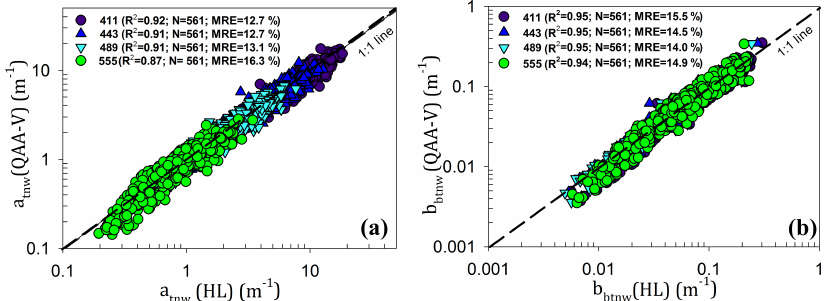
Figure 6. Validation of QAA-V on synthetic data (HL) for (a) a tnw and (b) b btnw at 411nm (dark blue), 443nm (blue), 489nm (cyan), and 555nm (green) wavelengths. MRE: absolute mean relative error (%).